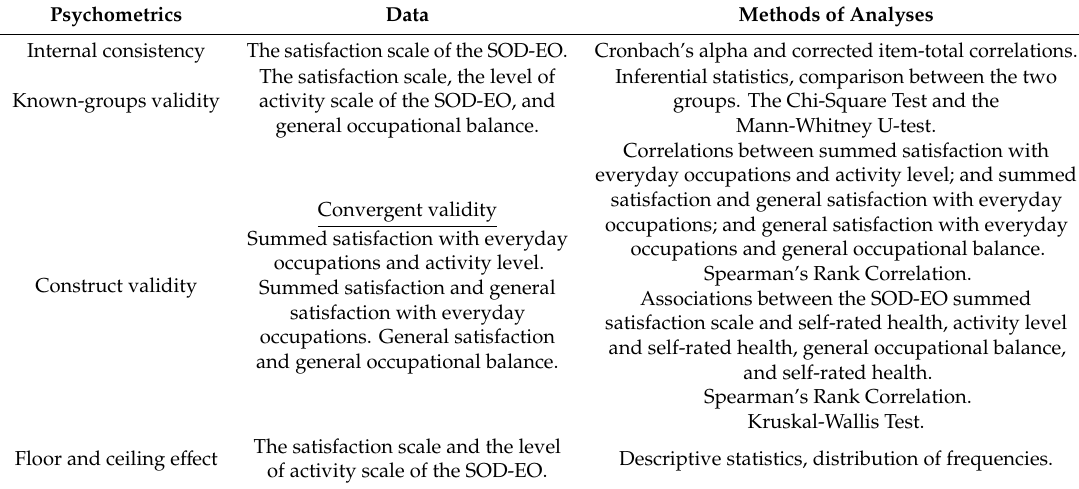
Table 2. Psychometric analyses, data, and statistical